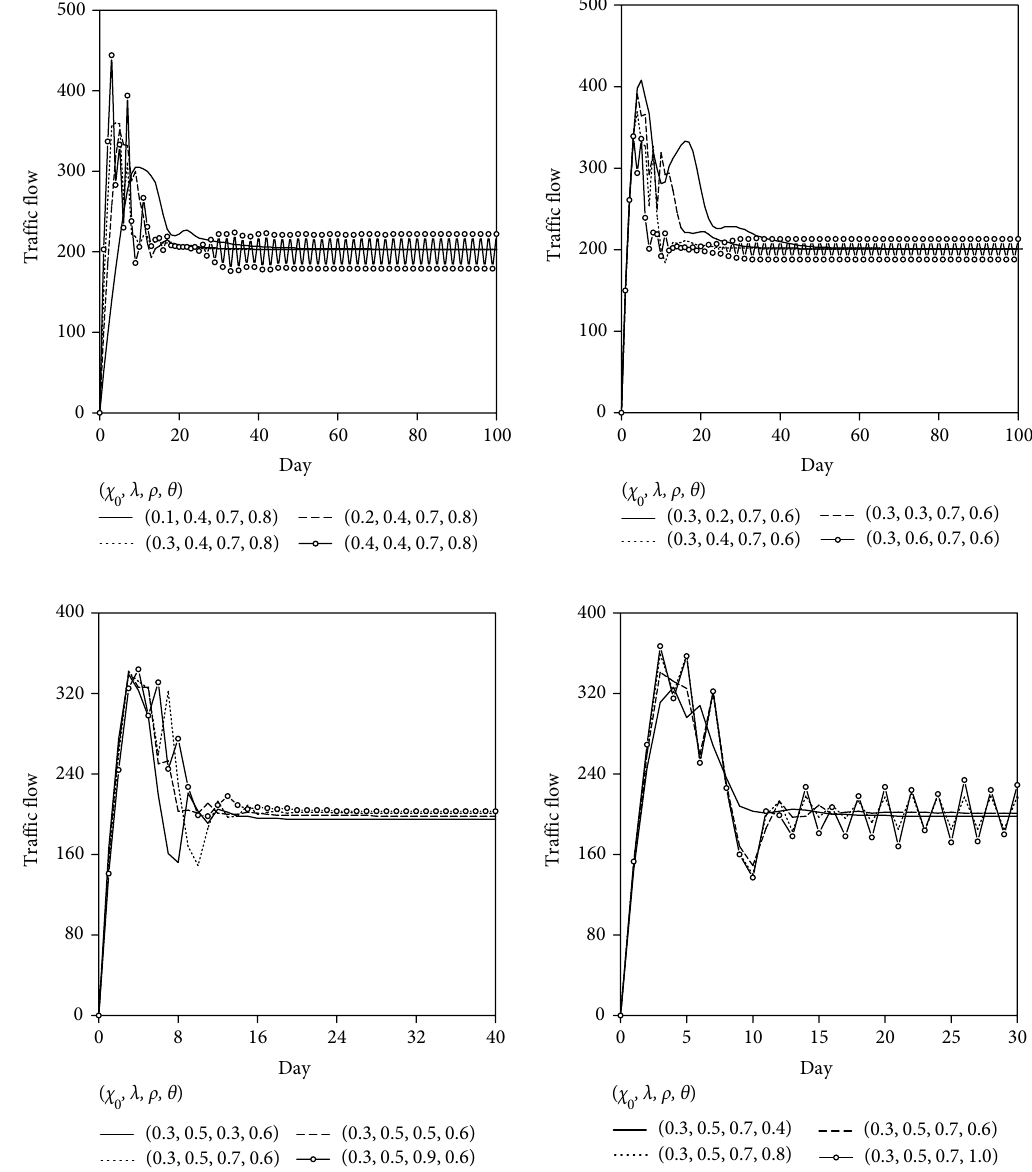
Figure 4: Evolutionary system with different parameter